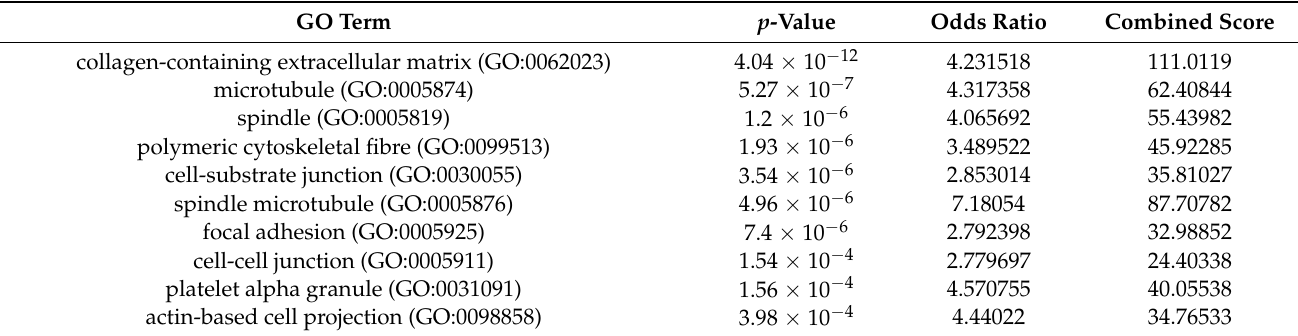
Table 4. The top 10 enriched GO terms in which the DEGs were significantly enriched, in the cellular component